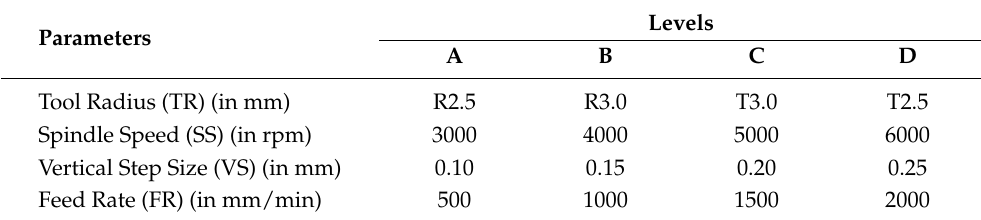
Figure 2. ( a ) Two kinds of forming tools used in the SPIF experiment; ( b ) scanned profile and CAD profile comparison against experiment; ( c ) 2D desired profile; ( d ) surface roughness measurement. Table 1. Input forming parameters and their level